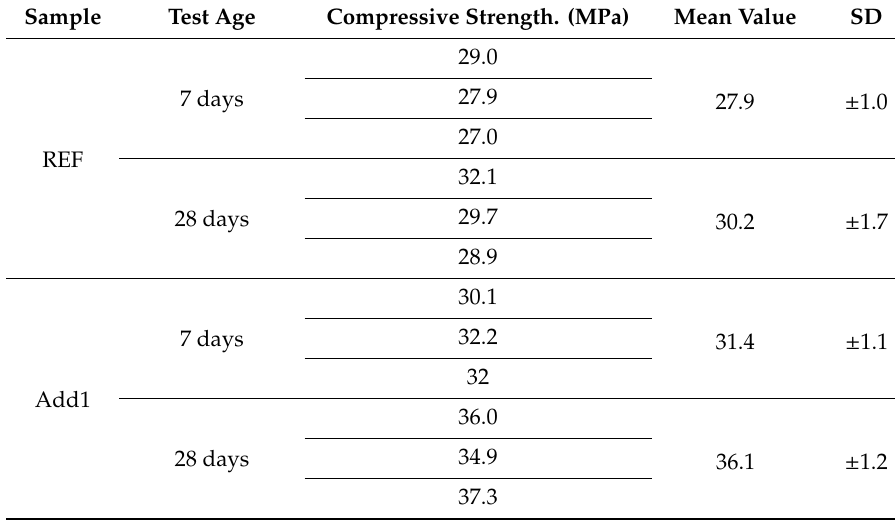
Table 3. Compressive strength values obtained in each of the samples tested, mean values and standard deviation